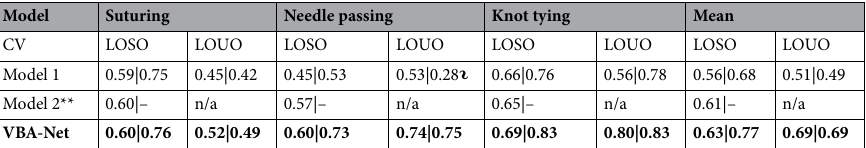
Table 2. Regression scores for LOSO & LOUO CV. At each cell, the format follows ρ OSATS |ρ GRS. Model 1: Zia and Essa 34 [2018] and Model 2: Fawaz et al . 9 [2019]. ⸊ p > 0.05. **Taken from respective authors’ papers but not included in the comparison. Significant values are in bold.